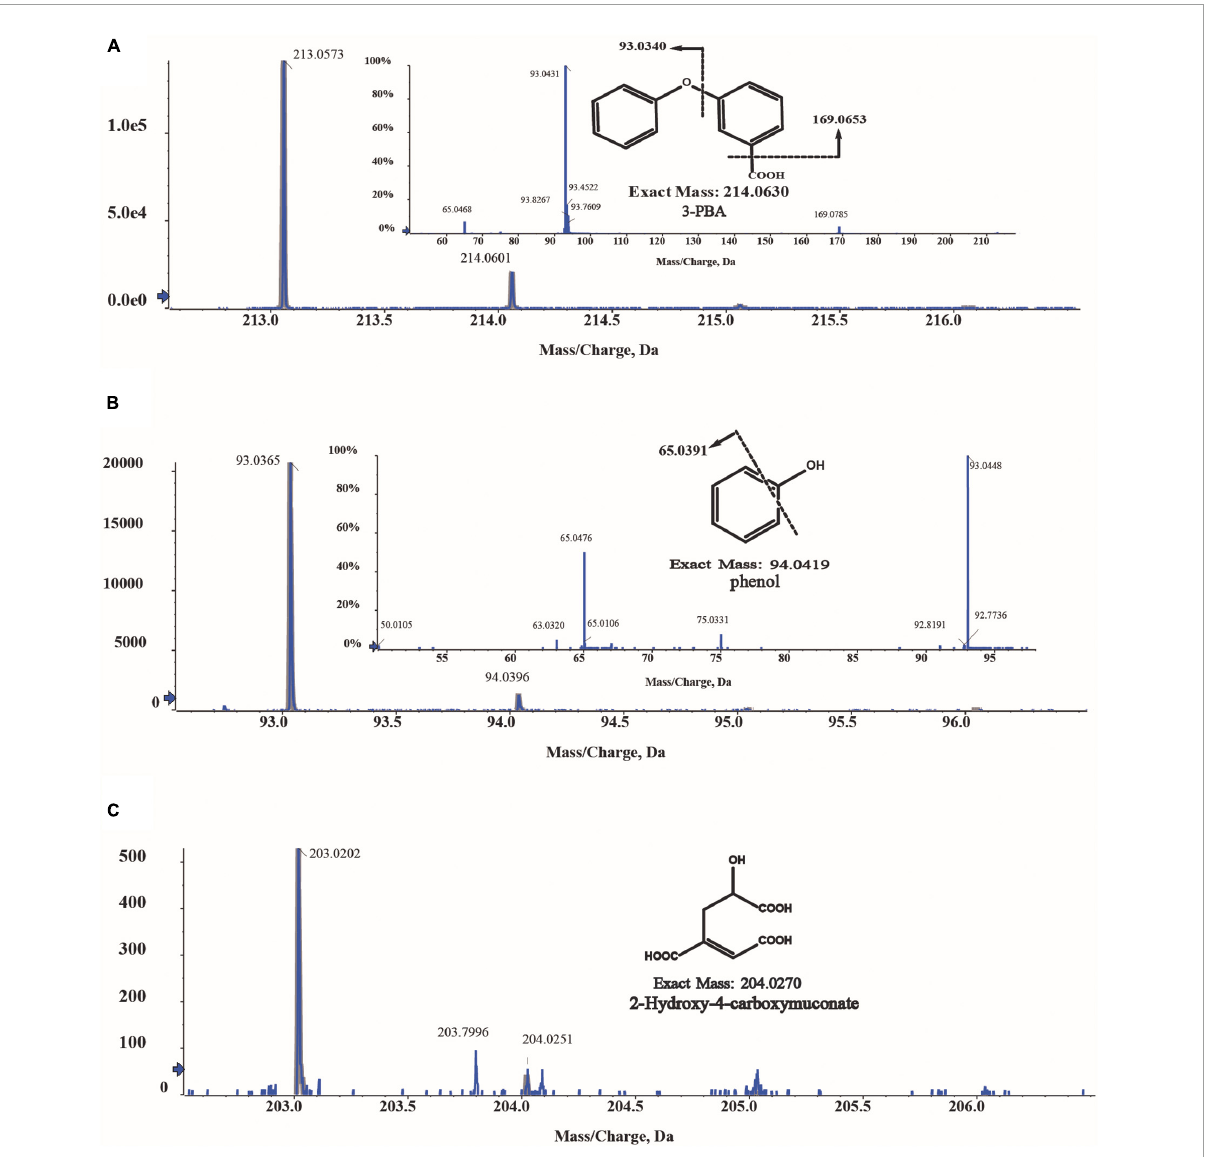
FIGURE6 MS/MS analysis of the metabolites of 3-PBA degradation by strain A-3. (A) MS/MS analysis of compound I; (B) MS/MS analysis of compound II; (C) MS/MS analysis of compound